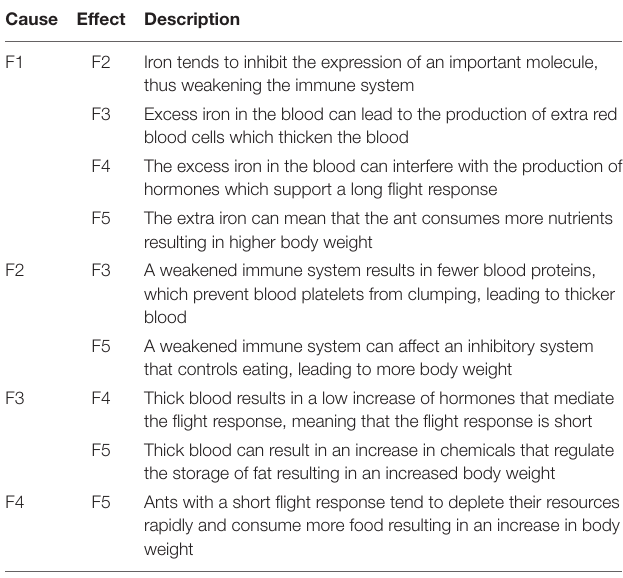
TABLE 3 | The casual structure for Kehoe ants (Studies 4 and